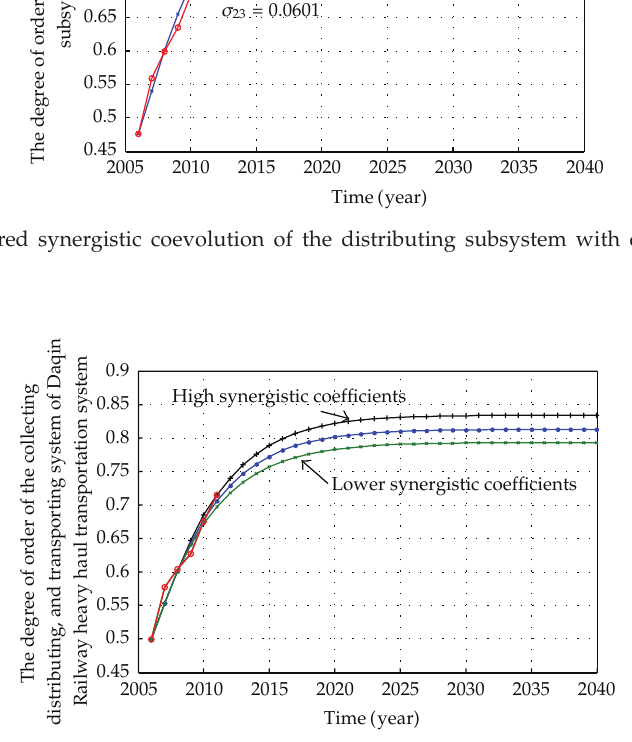
Figure 9: The ordered synergistic coevolution of the collecting, distributing, and transporting system of Daqin Railway heavy haul transportation with di ff erent synergistic coe ffi